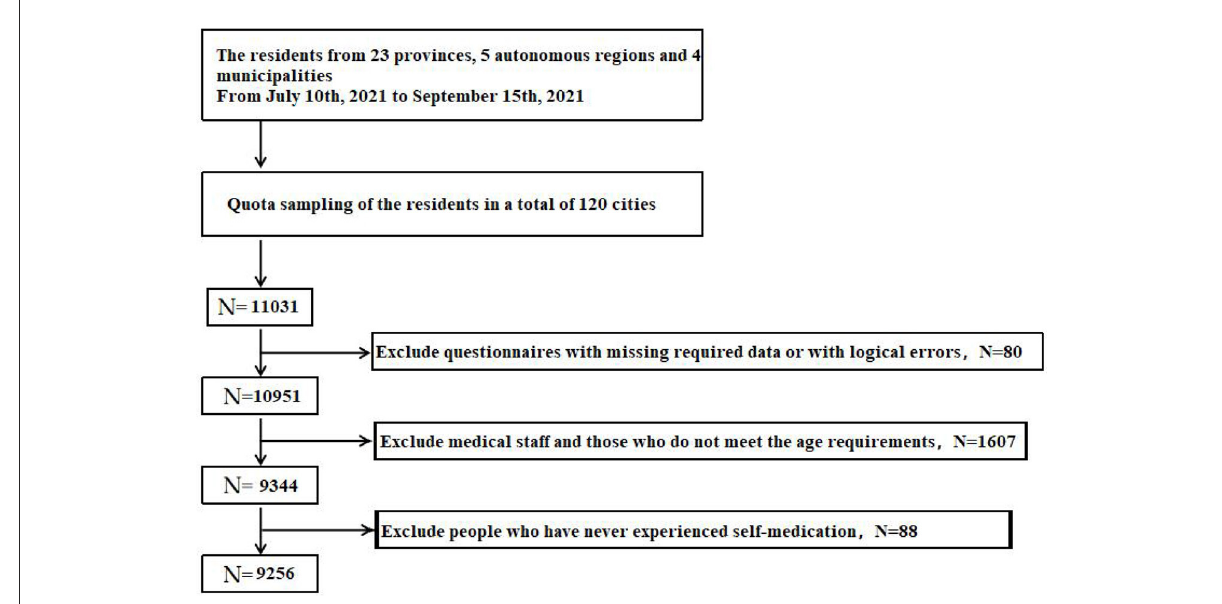
FIGURE1 The flow-chart